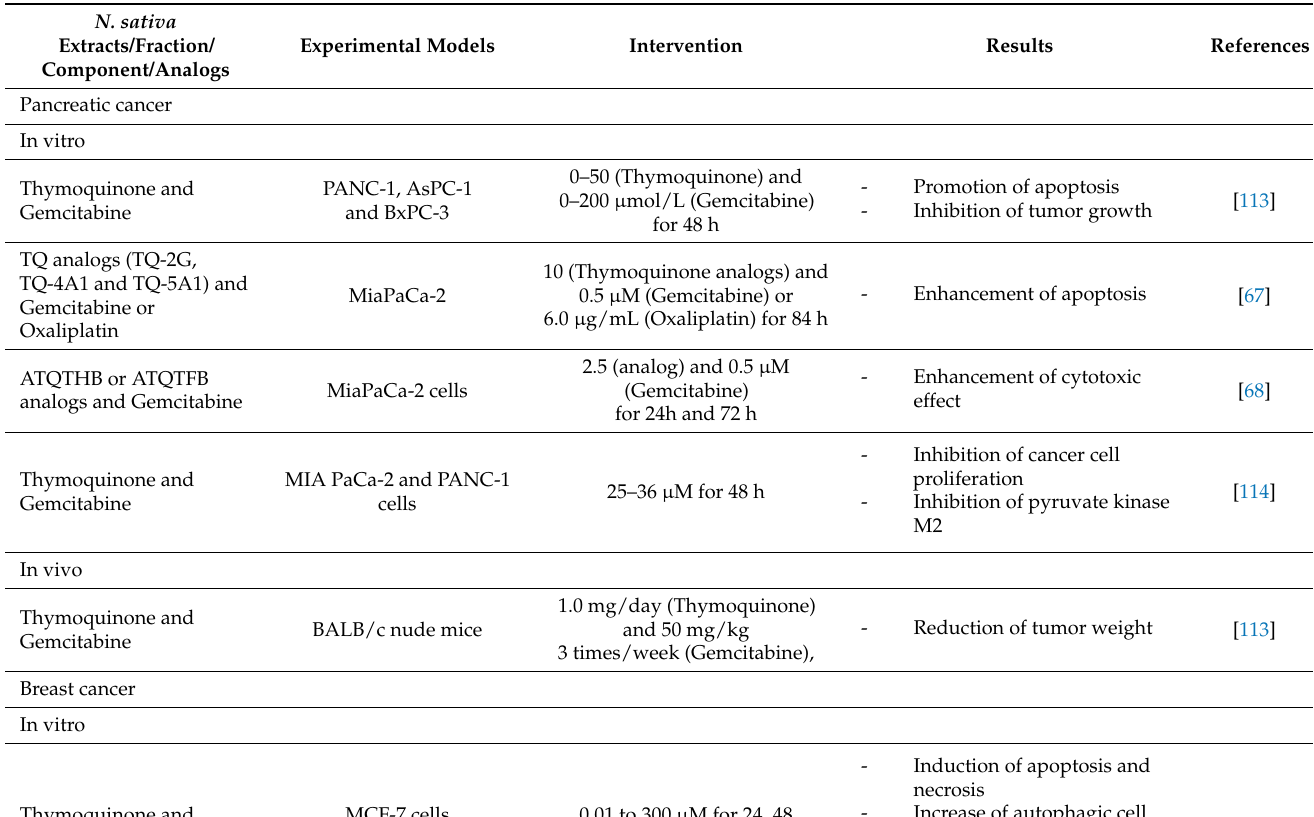
Table 4. Combined therapy of Nigella sativa and its constituents with anticancer drug and/or other bioactive molecule in vitro and/or in vivo models of various types of